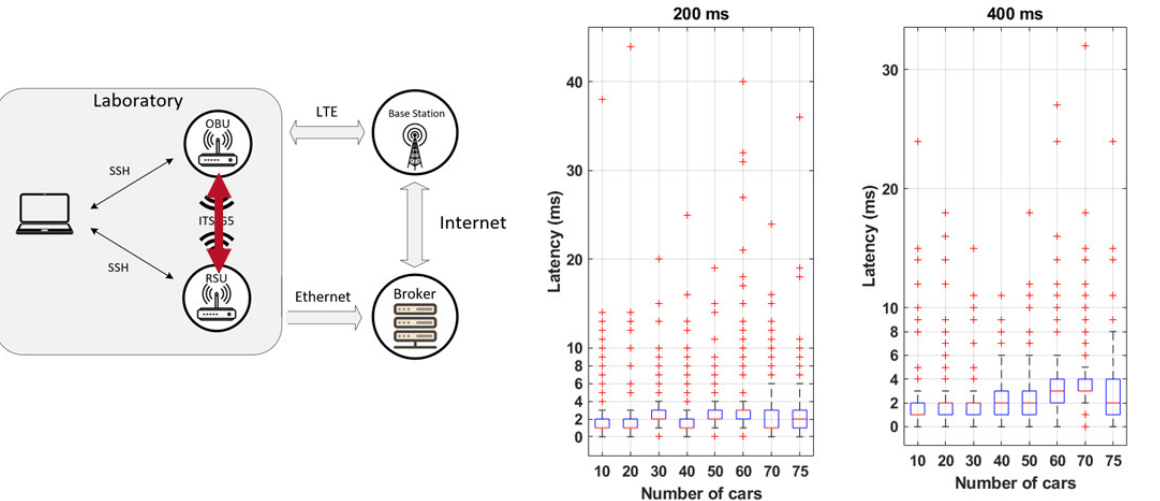
Figure 17. Latency values for 200 ms and 400 ms dissemination intervals using ITS-G5